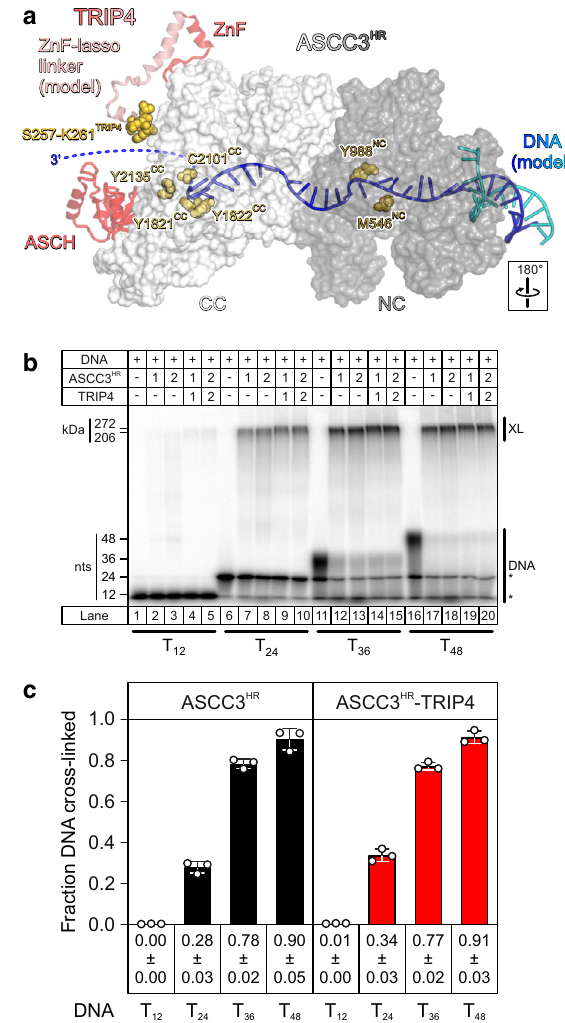
Fig. 4 | Path of DNA through the ASCC3 HR – TRIP4 complex. a Model of a ASCC3 HR – TRIP4 – DNA complex. ASCC3 HR , semi-transparent surface view (NC, dark gray; CC, light gray); TRIP4, semi-transparent cartoon view (red) with part of the TRIP4 ZnF-lasso linker region (light red) modeled with AlphaFold; 34 DNA modeled according to the DNA-bound Hel308 DNA helicase (PDB ID 2P6R) 40 , cartoon (blue and cyan); UV-cross-linked residues as identi fi ed by MS, spheres (gold). Cross- linked residues line the modeled path of the ssDNA region through both cassettes and exiting the CC near the TRIP4 ASCH domain (dashed blue line). Rotation symbol, orientation relative to Fig. 1c, d, left panels. b SDS-PAGE analysis mon- itoring UV-induced cross-linking of radio-labeled oligo-T DNAs (indicated at the bottom)toASCC3 HR (lanes2,3,7,8,12,13,17,18)ortotheASCC3 HR – TRIP4complex (lanes4,5,9,10,14,15,19,20).Lanes1,6,11,16,DNAsalone.Numbersabovethegel indicatetheamountsofASCC3 HR andTRIP4(1,100nM;2,200nM)addedto4.3nM radio-labeled DNA. Molecular mass markers in kDa or nucleotides (nts) are shown ontheleft,labeledbandsareidenti fi edontheright.Asterisks,bandsinT 24 ,T 36 and T 48 samples representing truncated synthetic products and DNA degraded during labeling and/or UV irradiation. c Quanti fi cation of the data in ( b ) obtained with samples containing 200nM ASCC3 HR or ASCC3 HR – TRIP4. Bars represent means± SD; n =3 technical replicates. Individual data points are shown as open circles. Source data are provided as a Source Data fi